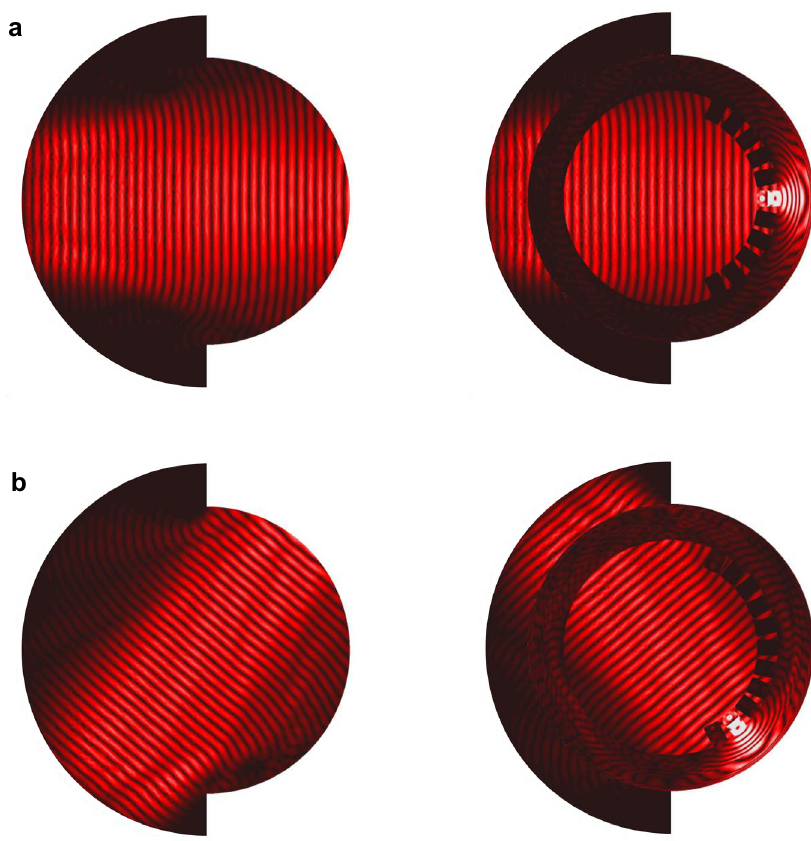
Fig. 8 Simulated (ANSYS HFSS) surface current distribution at 30 GHz. a Port 6, b Port